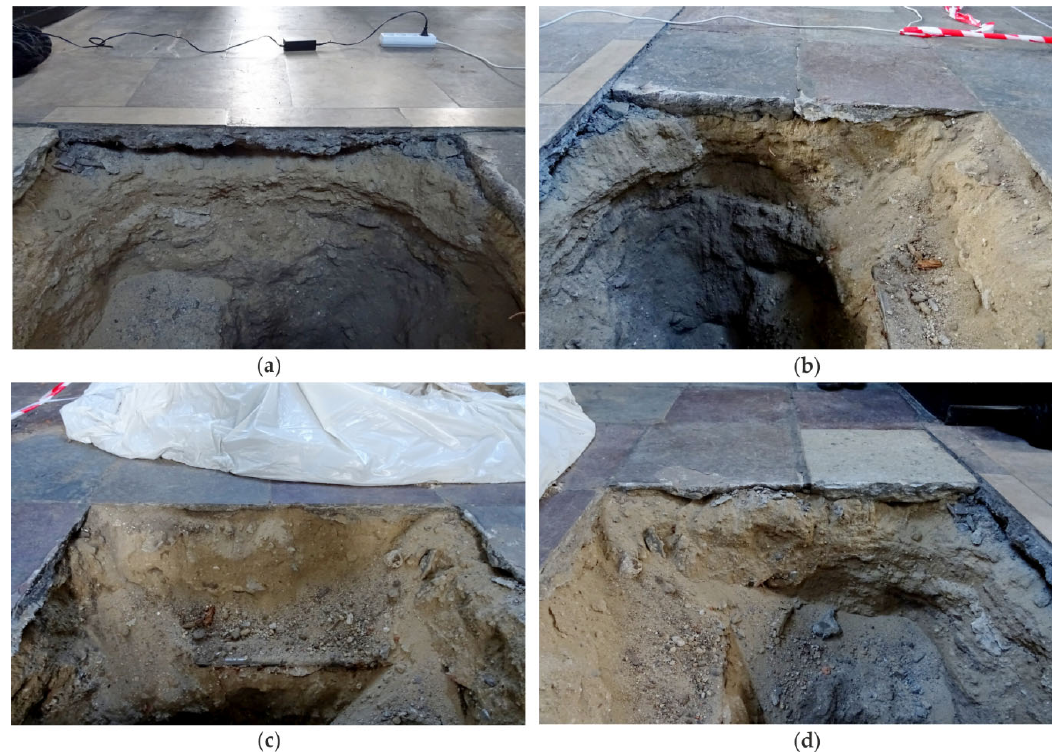
Figure 2. Photographs of the trial pit in the floor: ( a ) edge 1; ( b ) edge 2; ( c ) edge 3; ( d ) edge 4.